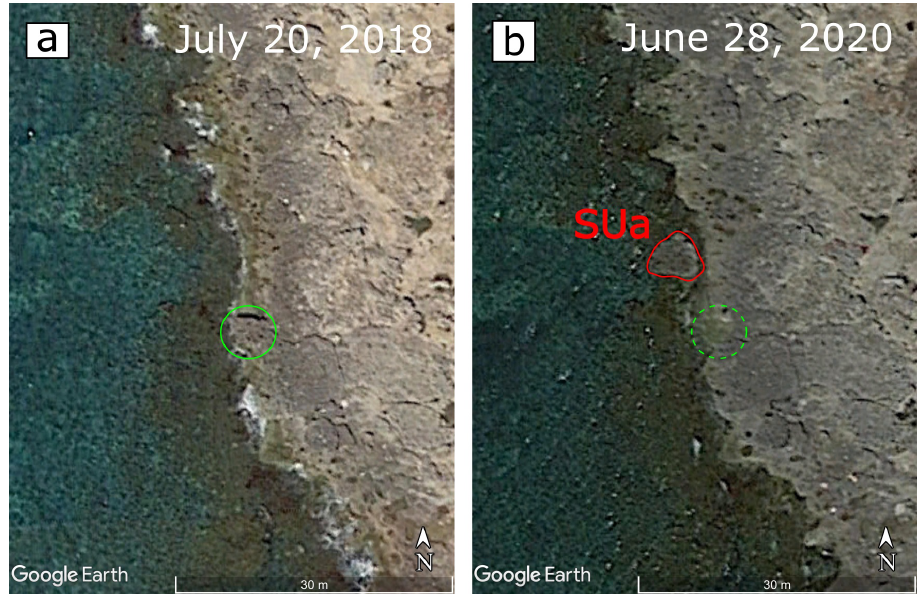
Figure A4. Comparative satellite images of the boulder SUa (Torre Suda): ( a ) The July 2018 image (eye elevation of 40 m); the green circle highlights the initial position. ( b ) The June 2020 image (eye elevation of 40 m).